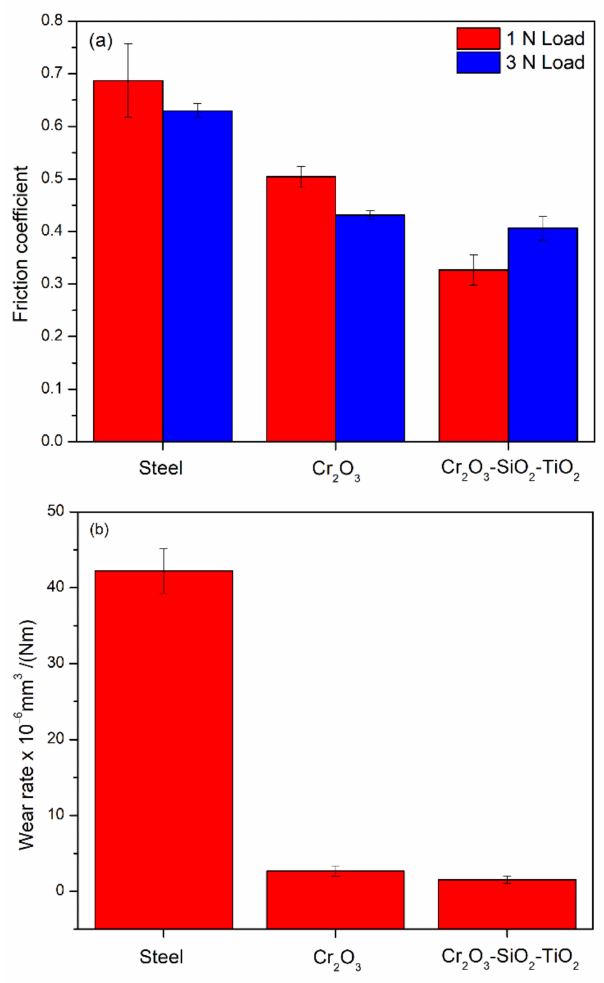
Figure 4. Steady-state friction coefficient values ( a ) and specific wear rates when 3 N load was applied ( b